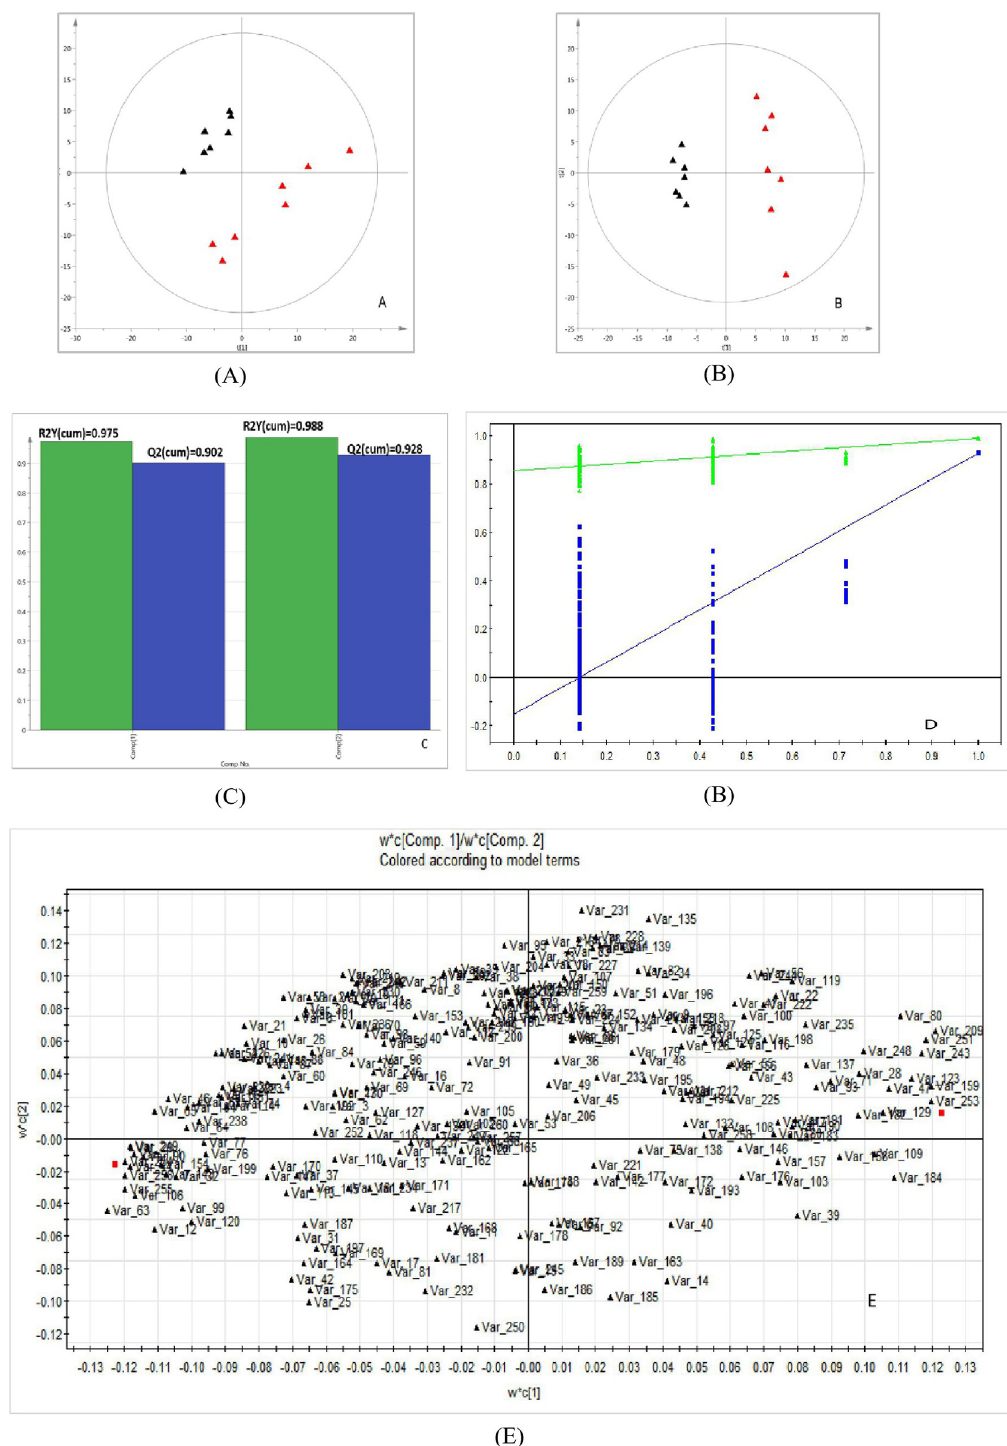
Fig 1. The metabolic profiles analysis of liver samples between two groups. (A) PCA score plots. (B) PLS–DA models. (C) Fit resutls of PLS-DA model. (D) permutation tests. Red represents the MetS model group, black represents the control group, Green 4 is for R2Y (cum), and blue □ is for Q2Y (cum). (E)The loading score plot of PLS-DA model.